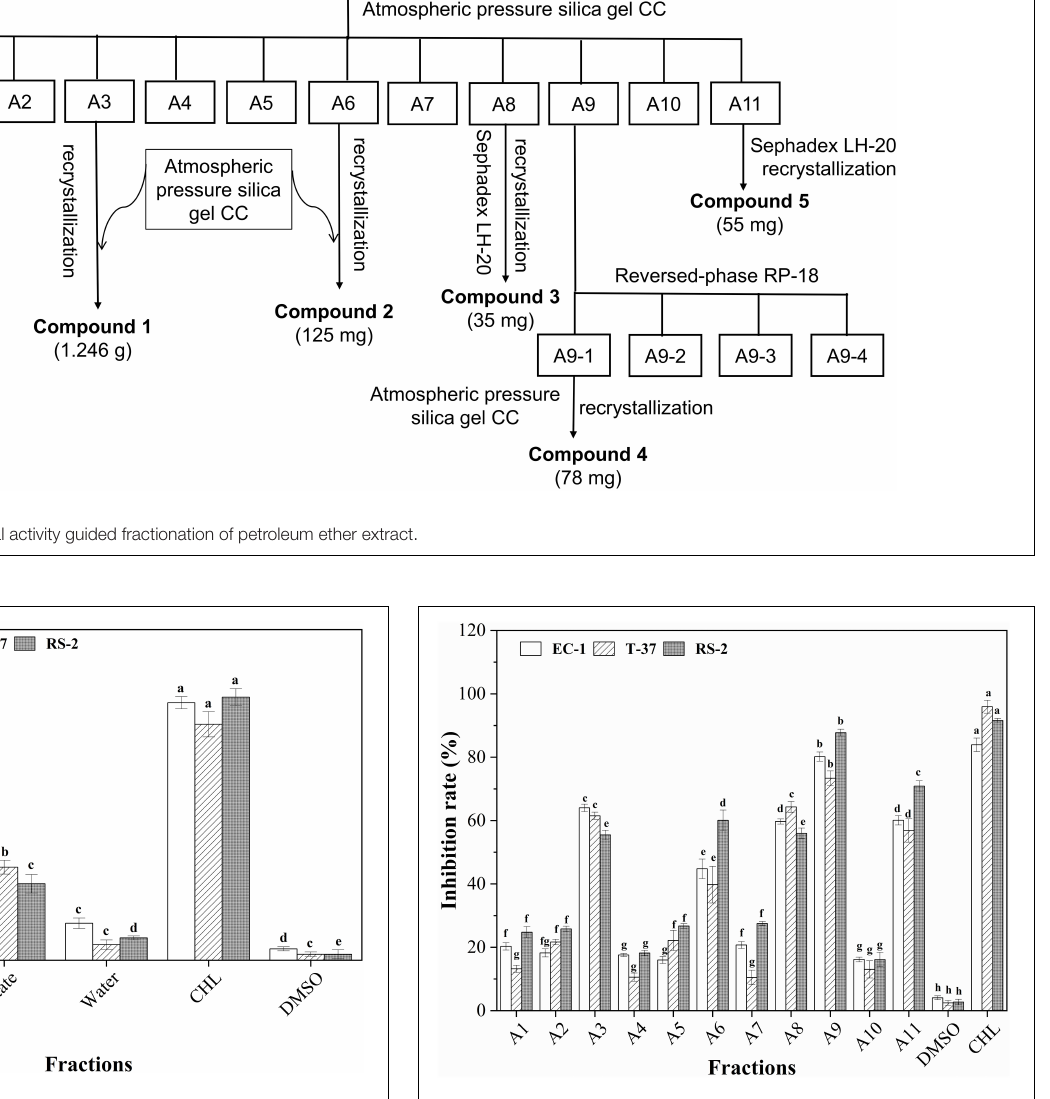
FIGURE 2 | Antibacterial activities of the organic extract fractions of the spore powder against the indicator bacteria. Different lowercase letters indicate significant differences ( p < 0.05). T-37, EC-1, and RS-2 represent Agrobacterium tumefaciens T -37, Erwinia carotovora EC-1, and Ralstonia solanacearum RS-2, respectively. DMSO represents dimethyl sulfoxide. CHL represents chloramphenicol.